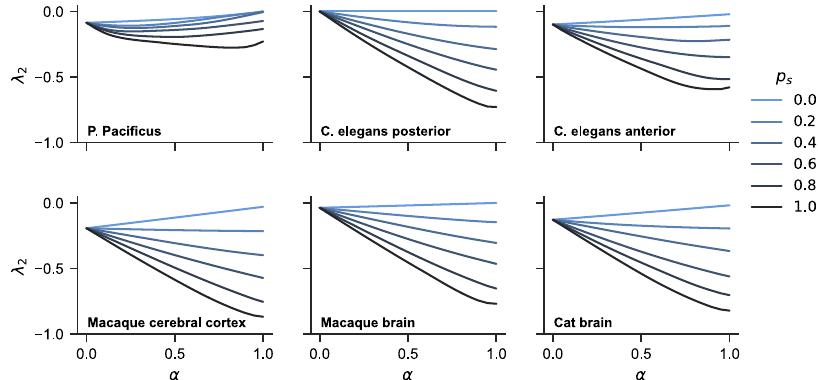
Fig. 5 | Synchronization stability of hypergraphs constructed from brain net- works. For each of the six brain networks, we start by attaching 2-simplices to closed triangles and turning the network into a simplicial complex. We then con- structhypergraphsatdifferentdistancesfromthe simplicialcomplexbyrandomly shuf fl ing the 2-simplices with probability p s . For each value of p s , we plot